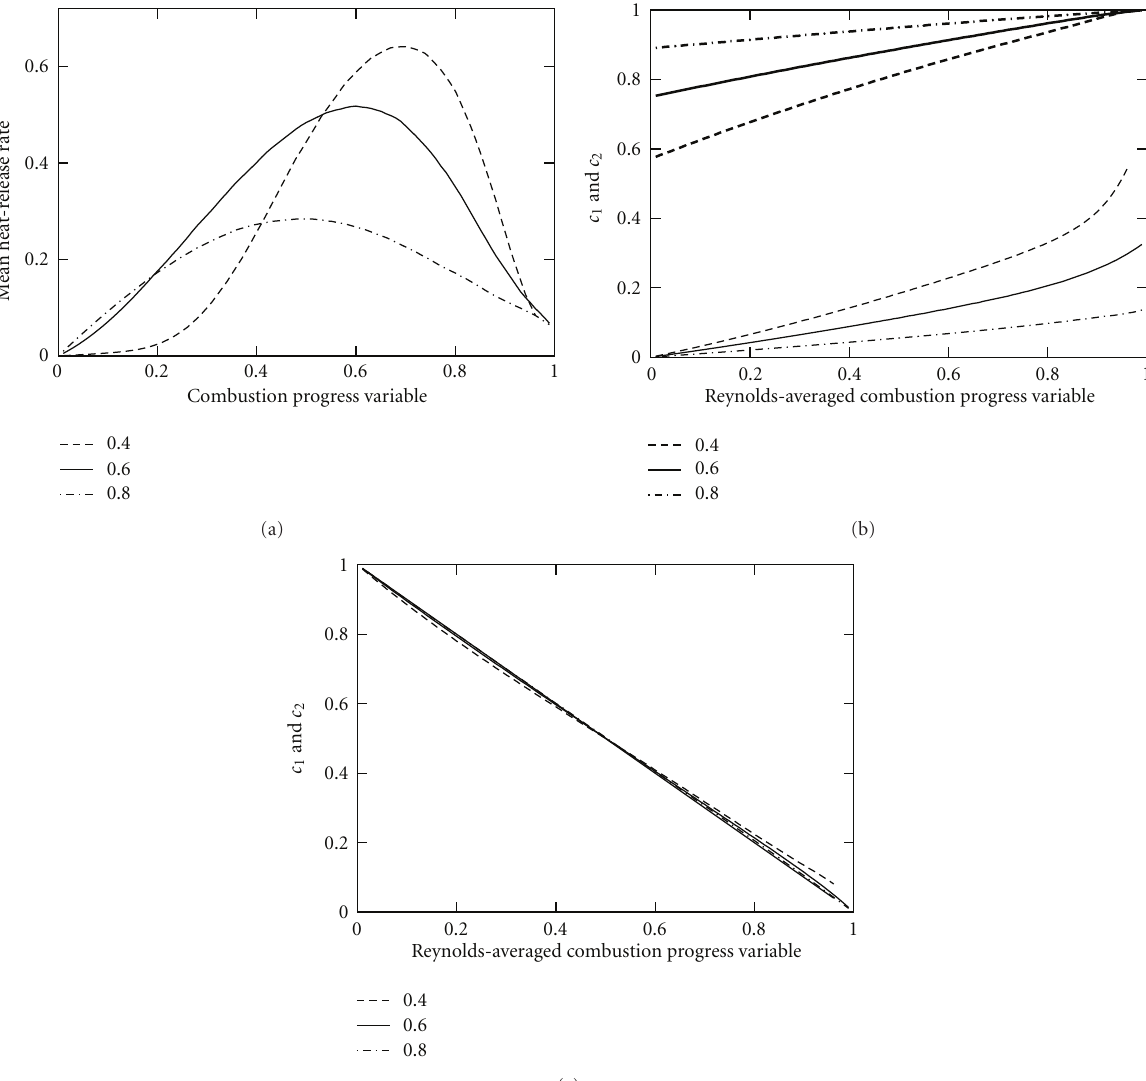
Figure 9: Dependencies of (a) the normalized mean heat release rate, (b) parameters c 1 (thin curves) and c 2 (bold curves), and (c) parameter α on the Reynolds-averaged combustion progress variable, calculated invoking the 2 δ -PDF for F = 1 . 6 and di ff erent segregation factors specified in